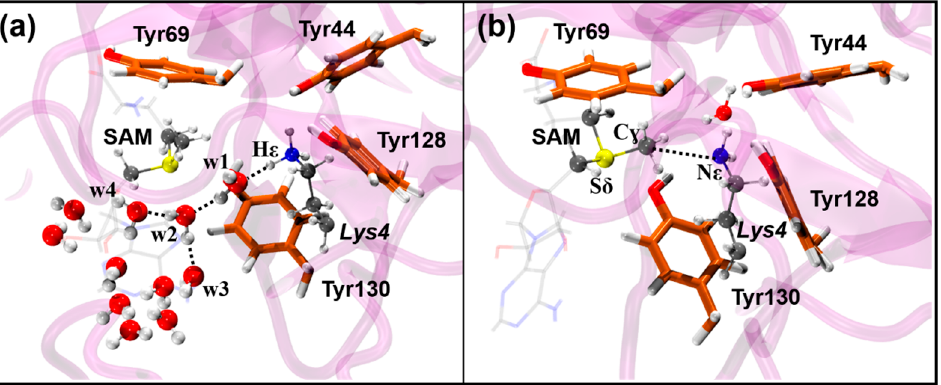
Figure 2. QM region used to study the ( a ) deprotonation and ( b ) methyl-transfer process. The respective reaction coordinates used to explore the transition states for each case are depicted. As the deprotonation reaction was found to be a highly concerted step occurring between the water molecules forming the water channel, there are several possible pathways denoted by the two routes shown in ( a ) towards w3 or w4. (enzyme’s carbon—orange; substrate and cofactor carbon—gray; red—oxygen; blue—nitrogen;